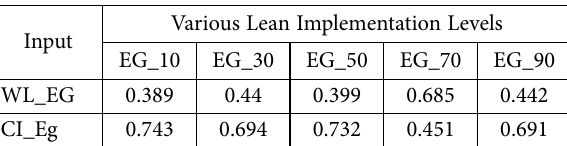
Table 10. Correlation coefficient for inputs and output